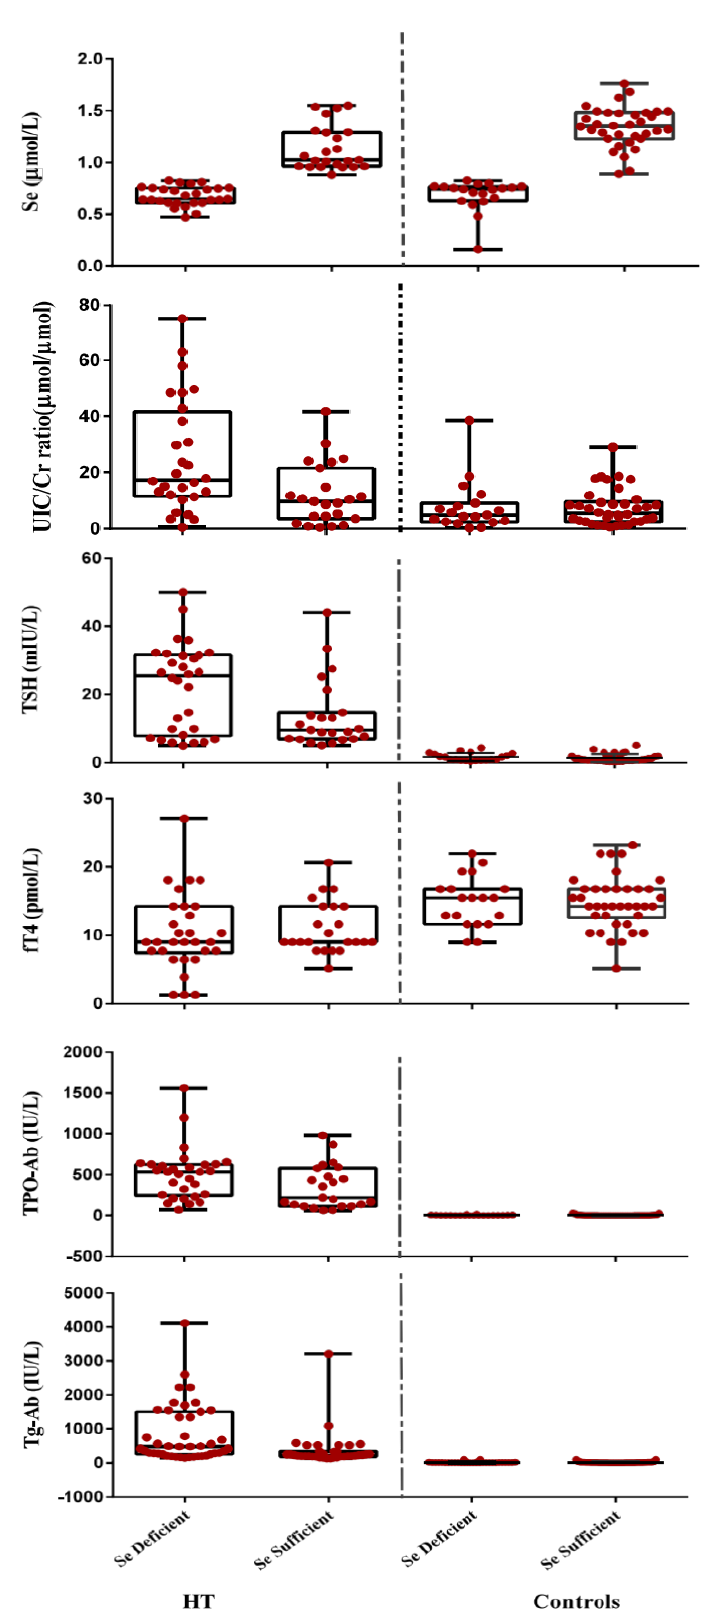
Figure 3. Box and whisker plots showing the levels of selenium, UiC/Cr, TSH, FT 4 , TPO-Ab and Tg-Ab HT in patients and controls (sufficient: > 0.85µmol/L and deficient: < 0.85µmol/L). The box describes first, second (median) and third quartiles. The whisker length represents minimum to maximum range. Each dot represents a single